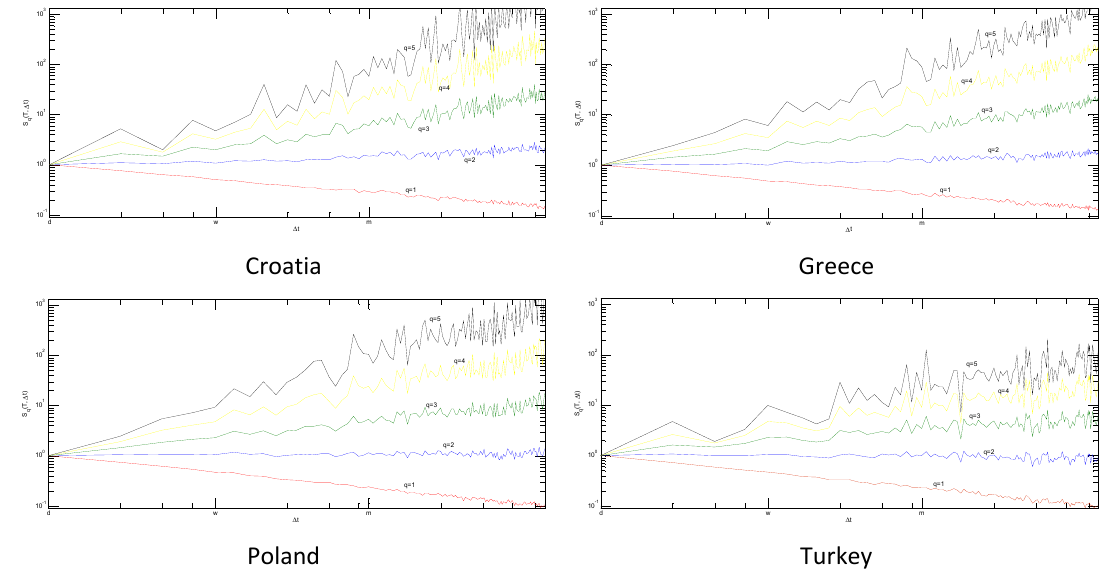
Figure 3. Partition functions of the log returns of the original series.